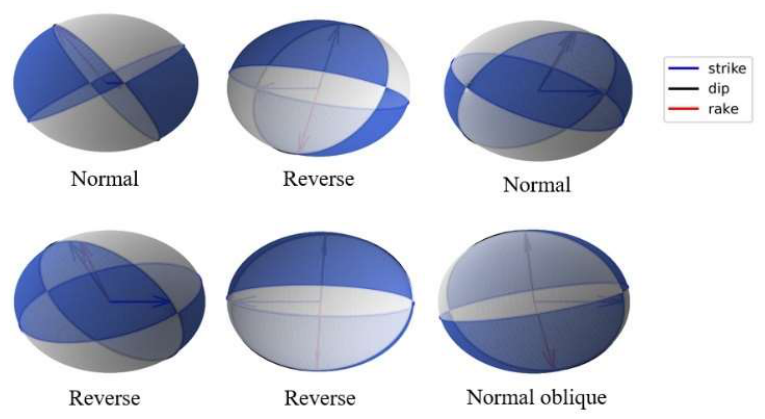
Figure 20. Beachballs in the 1314 working face. Figure 21. Fault plane solutions of the 1314 working face. Figure 21. Fault plane solutions of the 1314 working